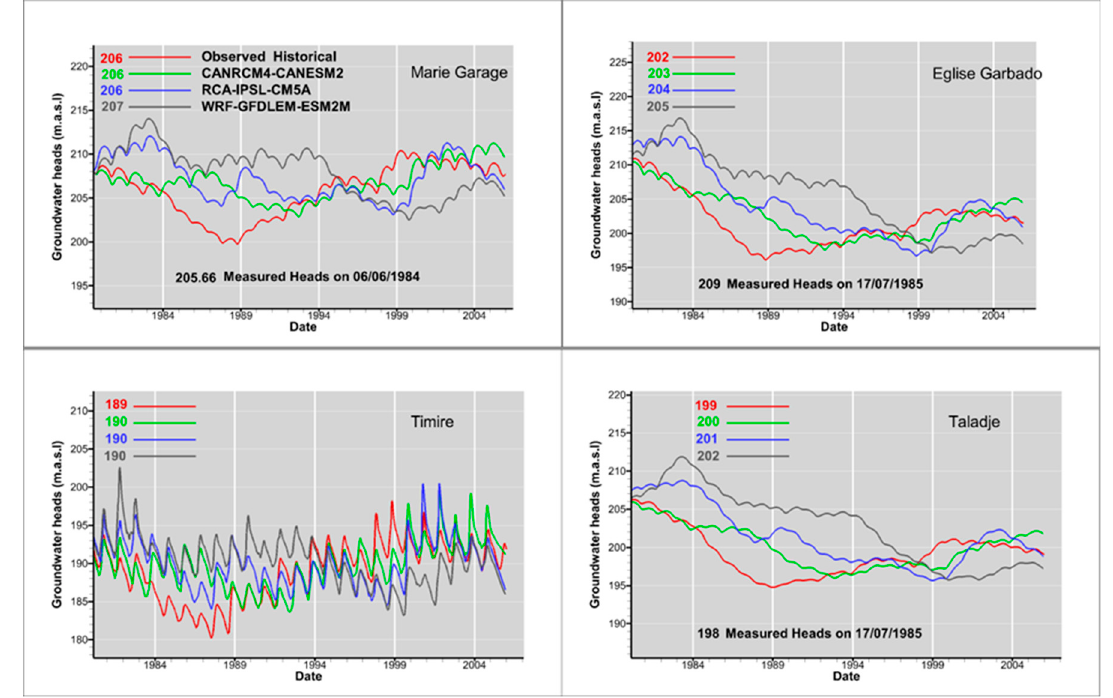
Figure 7. Simulated historical long-term (1980–2005) groundwater heads for the wells described in Table 2.